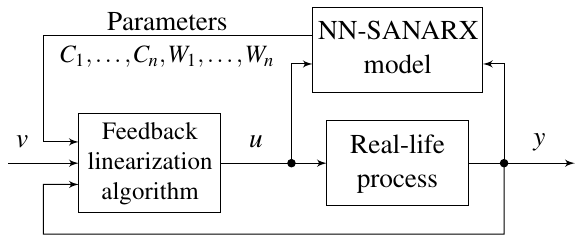
Fig. 2. General scheme of a control